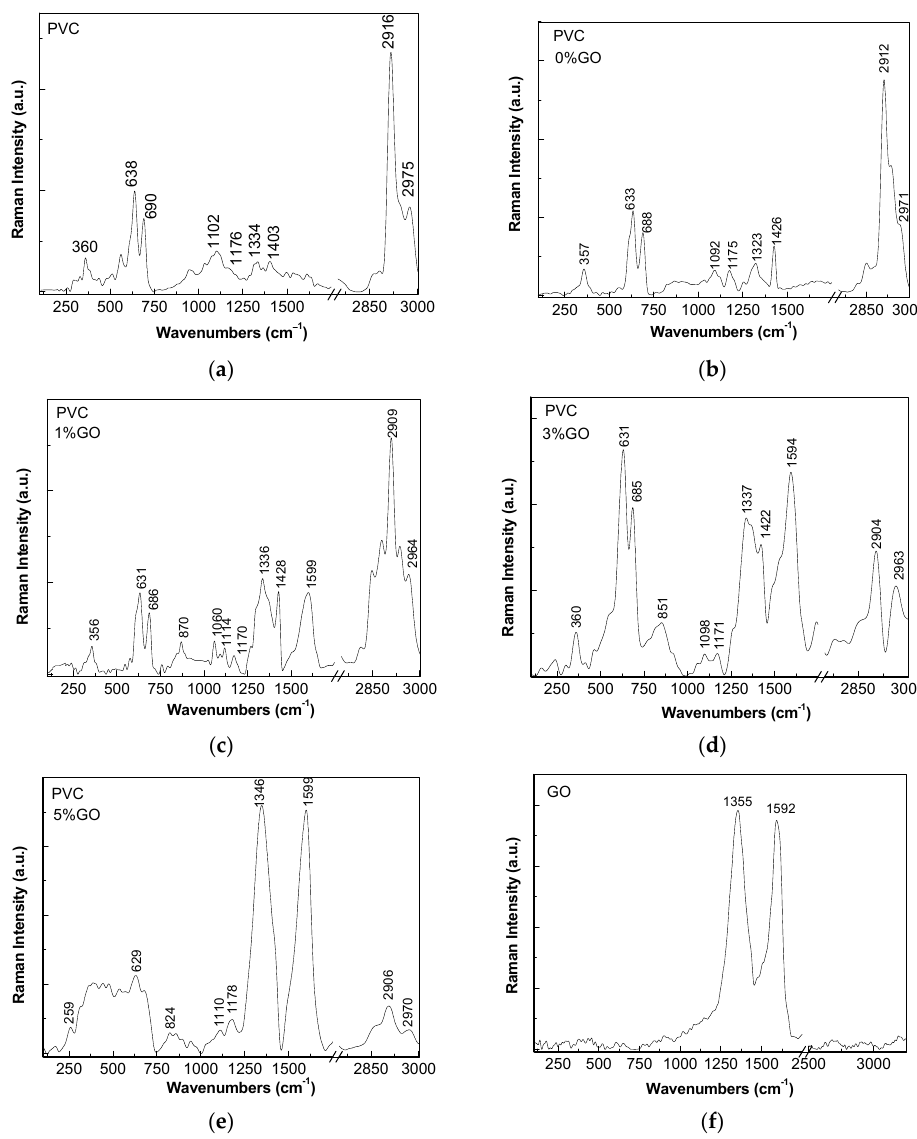
Figure 3. Raman spectra of the PVC grains ( a ), the PVC spheres ( b ), and their composites with GO when the concentration of GO sheets is equal to 1 wt.% ( c ), 3 wt.% ( d ), and 5 wt.% ( e ). GO sheets ( f ).